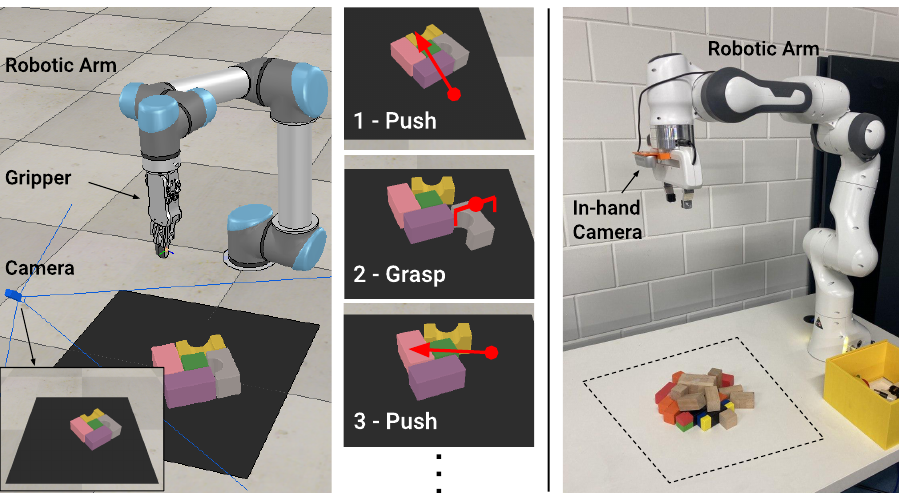
Figure 2. Robotic setups. On the left: the simulation environment consists of an UR5 robotic arm equipped with a two-finger gripper. An RGBD camera provides a side view of the workspace, which is delimited by the black square in front of the base of the robot. Objects are presented inside the workspace. On the right: th hardware environment consists of a Franka Panda robotic arm equipped with a two-finger gripper. An in-hand RGBD camera is used as a perception system. The workspace is software-limited to avoid collisions with the surrounding environment. Objects are presented inside the workspace. For both systems, the robotic arm in use must be able to grasp all the objects exploiting grasp-and-push